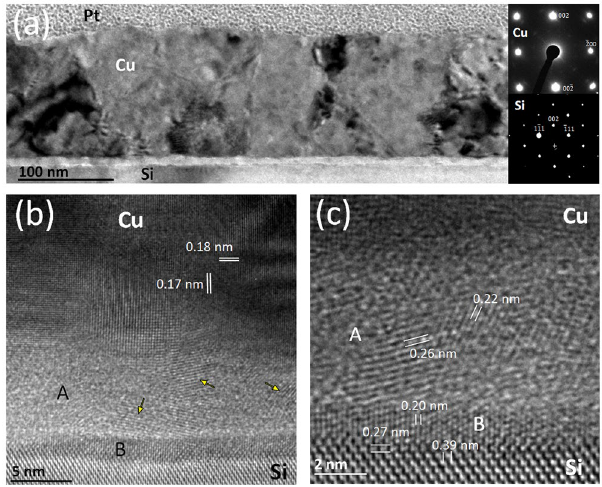
Figure 5. Cross-sectional TEM images of the HiPIMS Cu film grown at − 130 V bias on Si(001) substrate. ( a ) Low magnification FTEM image; SAED patterns of the Cu layer and Si substrate are shown in the inset. ( b ) and ( c ) HR-TEM images of the Cu/Si interface region showing distinct interfacial layers, labelled A and B. Yellow arrows indicate crystalline domains in region